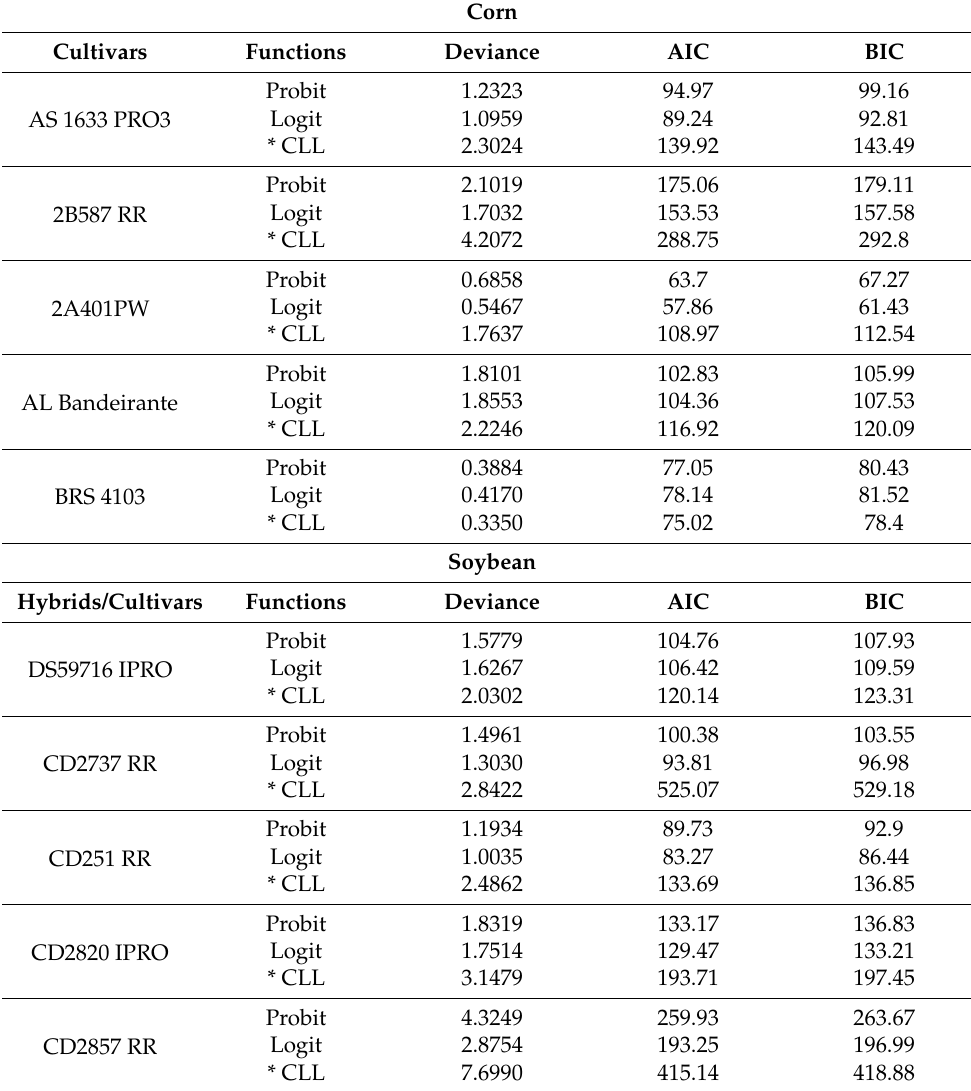
Table 3. Criteria for adjustment and selection of models for corn and soybean hybrids and/or cultivars.